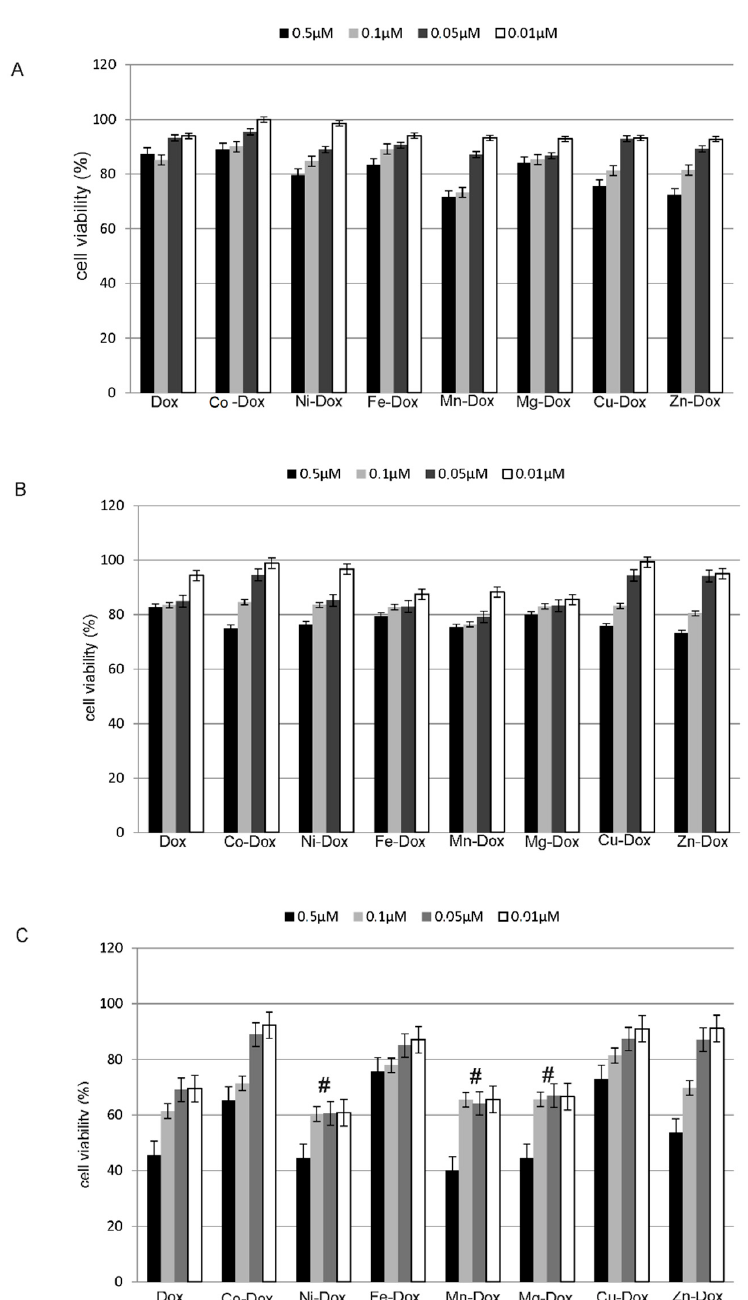
Figure 6. The effect of DOX, Cu-DOX, Zn-DOX, Co-DOX, Ni-DOX, Fe-DOX, Mn-DOX and Mg-DOX on cell proliferation of MCF-7 cells. The cells were incubated with 0.5 µM, 0.1 µM, 0.05 µM and 0.01 µM DOX and Metal-DOX complexes for 2 h ( a ), 4 h ( b ) and 24 h ( c ). Mean values from five independent experiments ± SD are shown. Significant alterations are expressed relative to DOX—controls and marked with crosses (#). Statistical significance was considered if # p < 0.05.